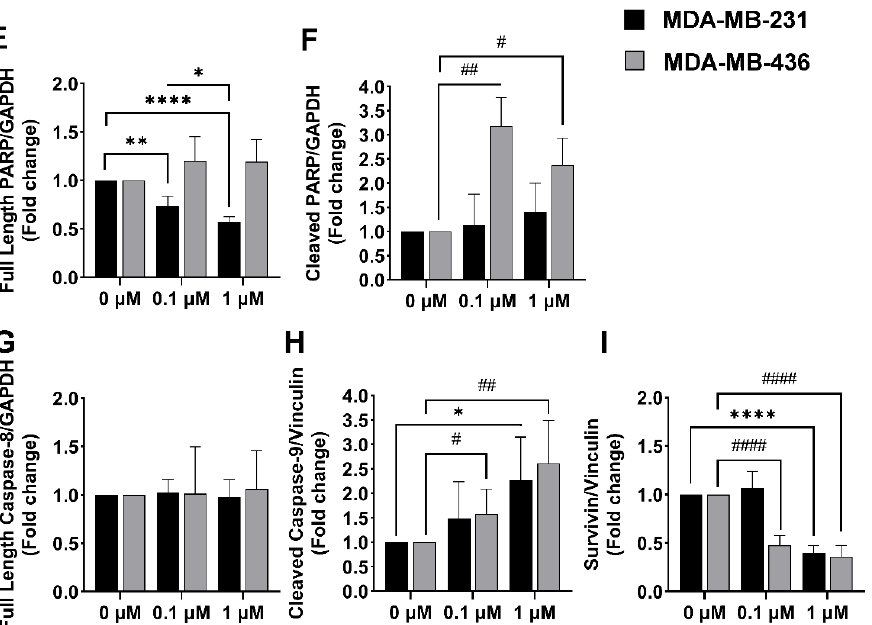
Figure 6. Western blot analysis and densitometry measurements of treated TNBC cell lines with arachidin-1 (A-1, 0.1, and 1 µM). Western blot images of ( A ) PARP and cleaved PARP, GAPDH loading control. ( B ) Full-length caspase-8, GAPDH loading control; ( C ) cleaved caspase-9, vinculin loading control; and ( D ) survivin, GAPDH loading control. Lysates (60 µg of total protein) of MDA-MB-231 and MDA-MB-436 cells treated with A-1 were analyzed by western blotting. The relative densitometry of ( E ) full-length PARP, ( F ) cleaved PARP, ( G ) caspase-8, ( H ) cleaved caspase-9, and ( I ) survivin protein levels were analyzed by comparing to the loading control. Cells with 0.01% DMSO were used as controls. Data represents mean ± SD from three or more independent experiments. * p < 0.05, ** p < 0.001, *** p < 0.0001, **** p < 0.0001 versus control in MDA-MB-231, # p < 0.05, ## p < 0.001, ### p < 0.0001, #### p < 0.00001 versus control in MDA-MB-436, and ns = not significant from control.